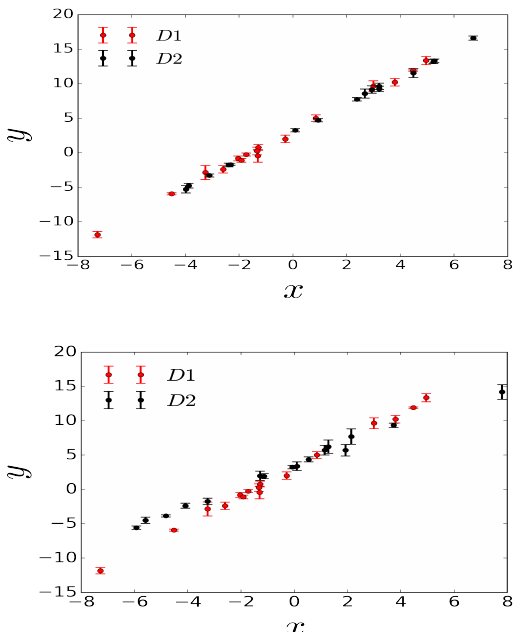
Figure 8. Datasets D 1 and D 2 measured by the straight-line theory. Top: case 1. Bottom: case